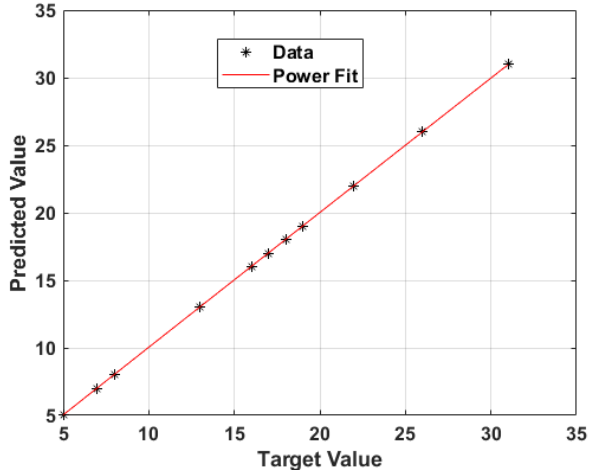
Figure 16. System failure plot of target vs. predicted value for ANN Model 1